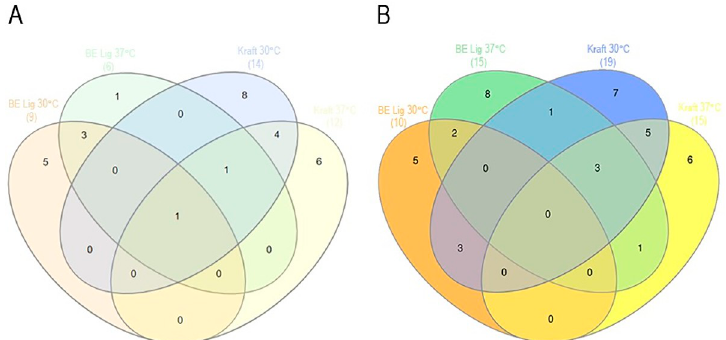
Fig 4. Venn diagram of bacterial genera present at the 6 th passage of enrichment in consortia obtained using either base-extracted (BE-Lig) or Kraft lignin (Kraft) as carbon source at cultivation temperatures of 30˚C and 37˚C. Shown in parenthesis is the number of genera for each growth condition with relative abundance above 1%. (A) Bacterial consortia derived from MG compost. (B) Bacterial consortia derived from backyard (BY) compost.